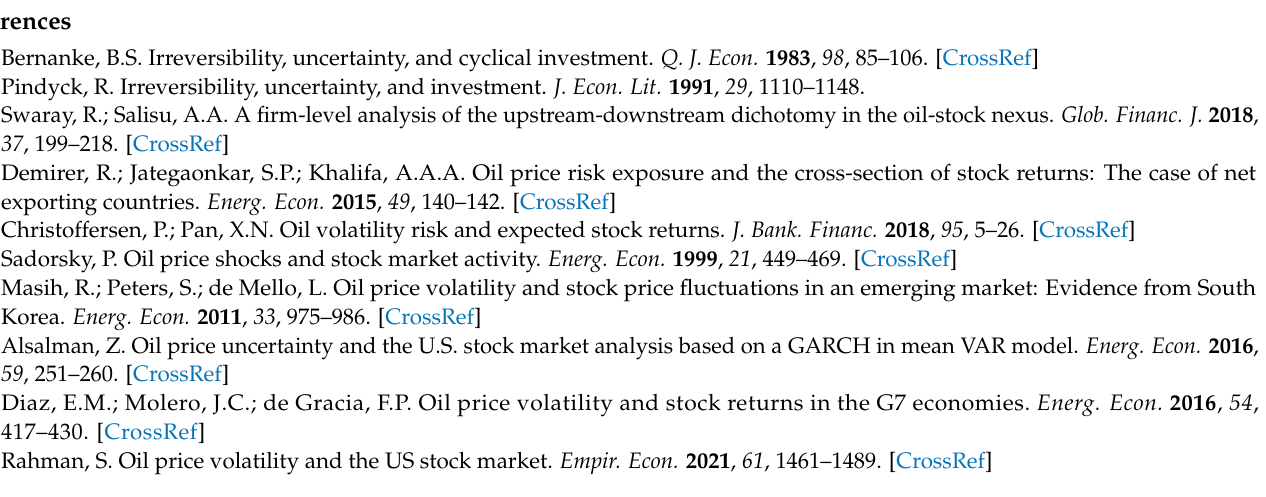
Figure A2. Full-sample quantiles-based response of stock returns to oil price uncertainty ( OIL_UNC ).